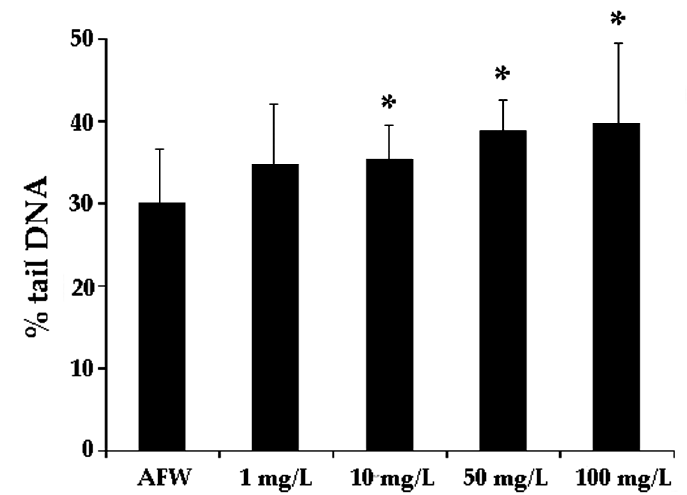
Figure 1. DNA primary damage (% tail DNA) in zebra mussels’ haemocytes after 48 h of exposure to the following experimental groups: AFW (control); 1–10–50–100 mg/L Zn(II)nominal doses in AFW. Data are shown as mean ± SD. (*) indicates significant difference respect to the control group (AFW) ( p < 0.05).